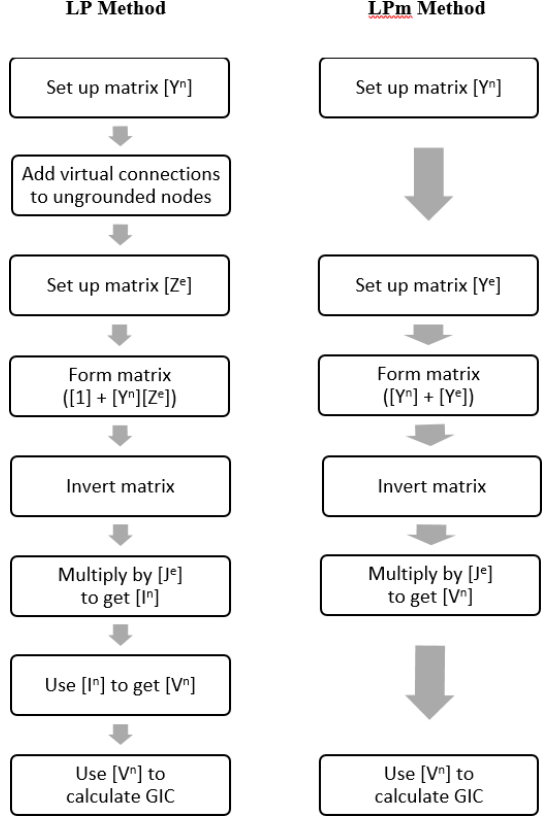
Figure 2. Comparison of the steps involved in the LP and LPm